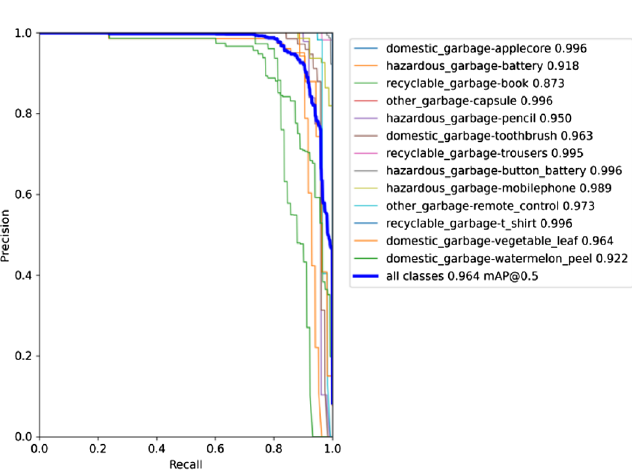
Figure 14. Accuracy rate curve of the YOLOv5s-CSS network model.